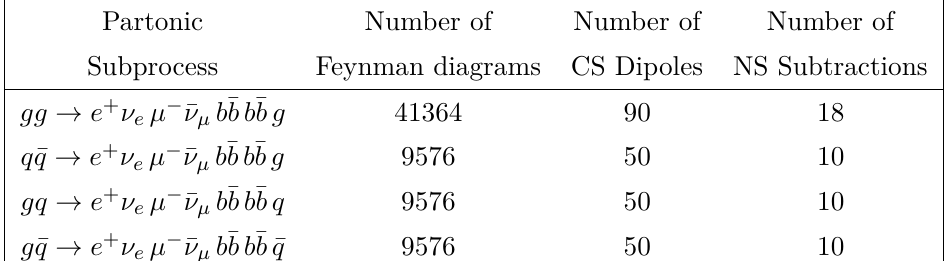
Table 2 . The list of partonic subprocesses contributing to the subtracted real emission at O ( α 5 for the pp → e + ν e µ − ¯ ν µ b ¯ b b ¯ b + X process where q = u, d, c, s . Also shown are the number of Feynman diagrams, as well as the number of Catani-Seymour and Nagy-Soper subtraction terms that correspond to these partonic